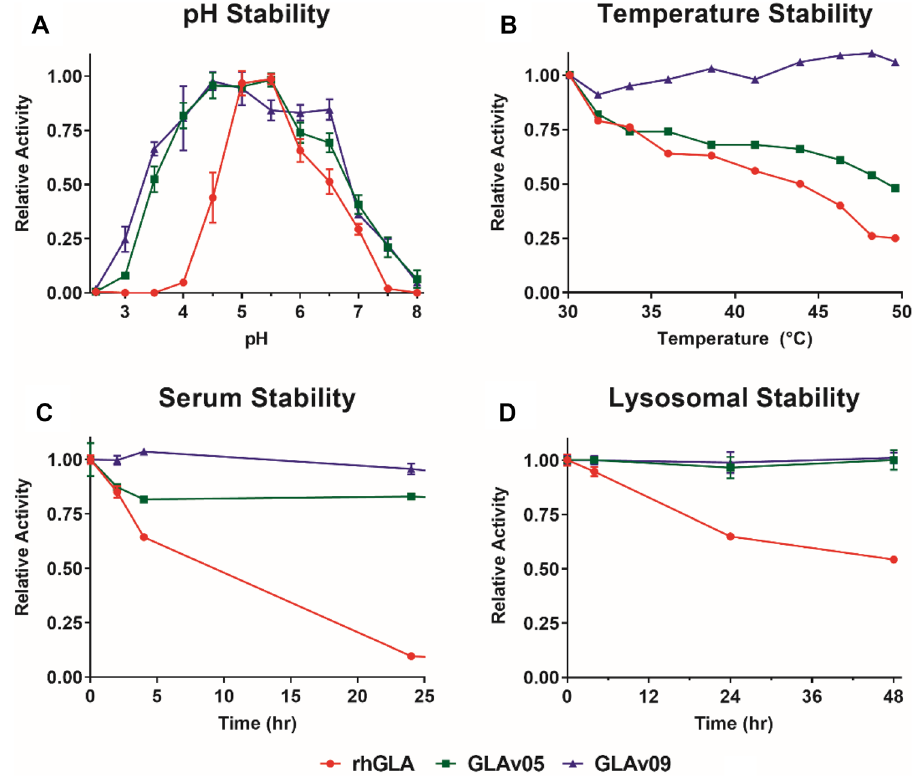
Figure 2. Stability of GLA variants. The activity of each variant (GLA (red circles), GLAv05 (green squares), and GLAv09 (blue triangles) was measured in a 4-MU-Gal hydrolysis assay following the indicated challenge conditions (three technical replicates per sample, except for heat challenge which shows results of a single test at each data point). ( A ) Enzymes were pre-incubated at the indicated pH for 24 h (n = 3). ( B ) Enzymes were pre- incubated at the indicated temperature for 1 h (n = 1). ( C ) Enzymes were incubated in human serum at 37 °C and assayed at indicated timepoints (n = 3). ( D ) Enzymes were incubated in human liver lysosome extracts at 37 °C and assayed at indicated timepoints (n = 3).